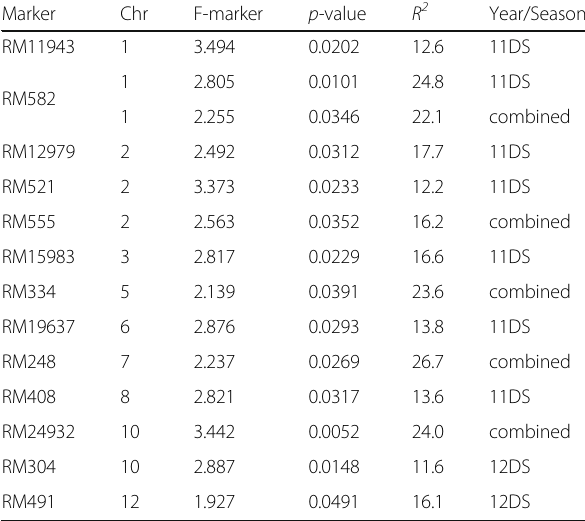
Table 4 Markers significantly associated with grain yield under non-stress